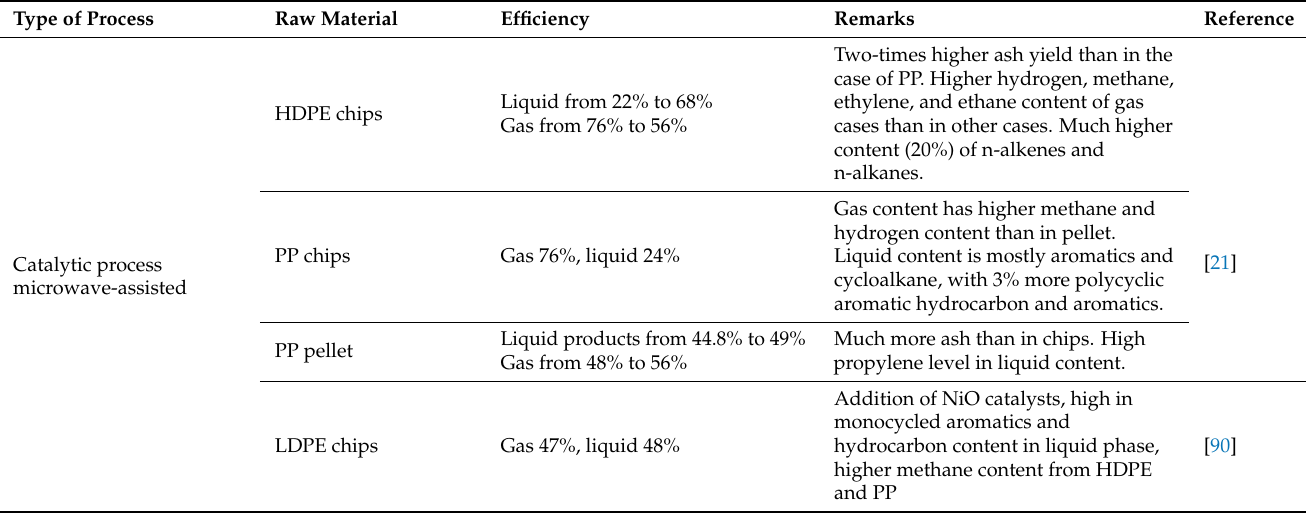
Table 5. Comparison of the processes used due to different